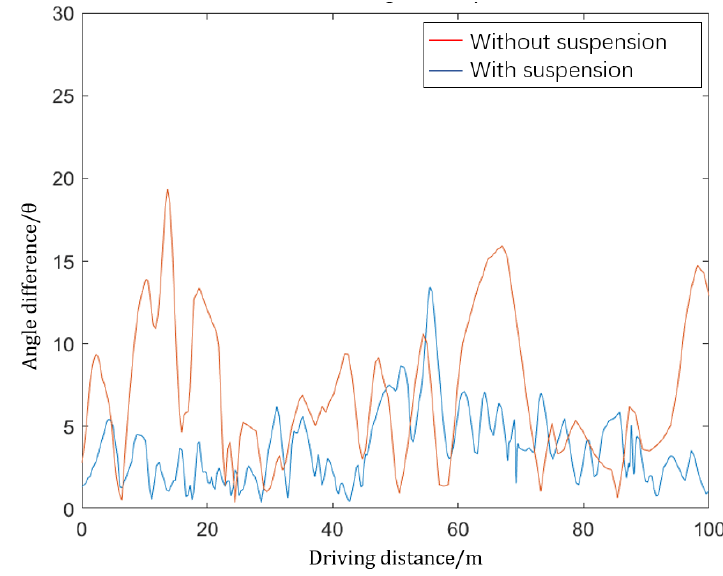
Figure 20. Comparison of rover attitude.